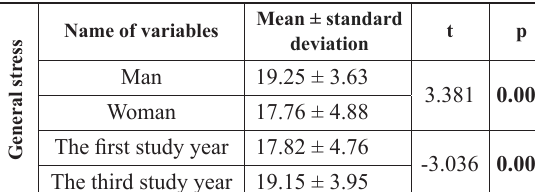
Table 1. Comparison of general stress between gender and study year